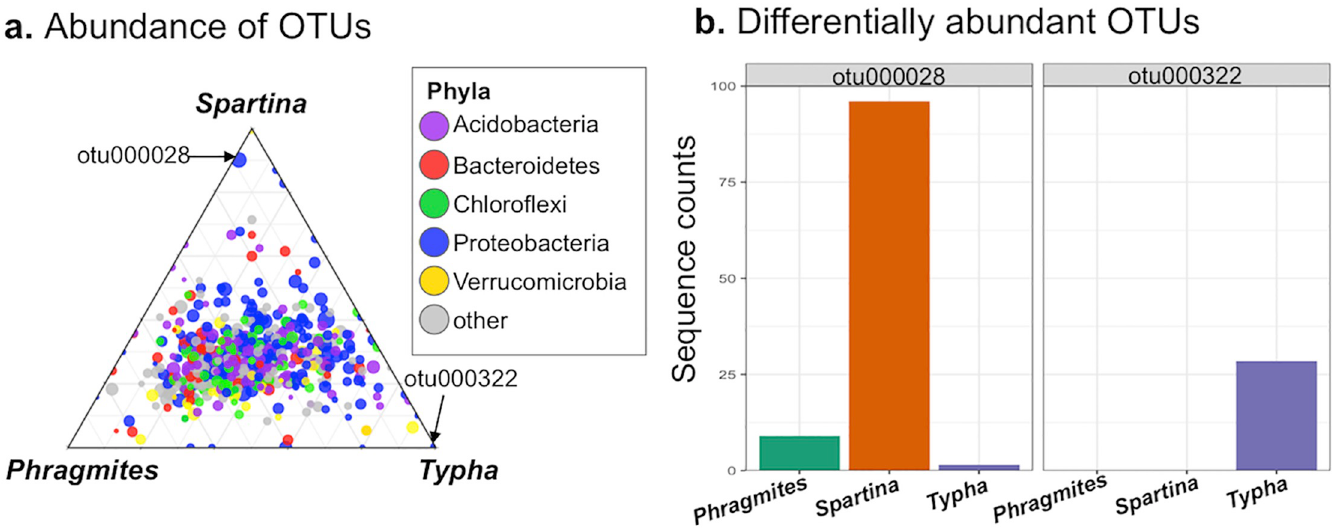
Fig 7. OTU relative abundance in association with vegetation. Only the 1500 most abundant OTUs are displayed. (a) Ternary diagram displaying OTU abundance among the three plant species. The two OTUs identified as significantly different in relative abundance are indicated by the arrows. (b) Median counts per sample of each of the differentially abundant OTUs. A table showing the classification of the differentially abundant OTUs is shown in S1 Table.